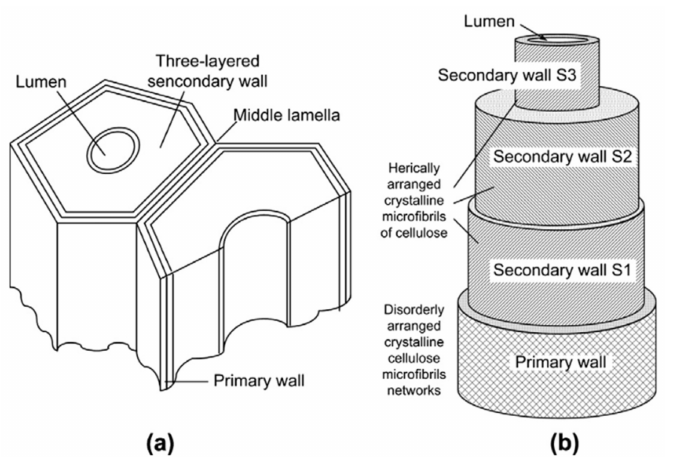
Figure 2. ( a ) Cross section cell arrangements and ( b ) structural of single fiber. Reproduced with permission from [26]. Copyright 2012 Elsevier.